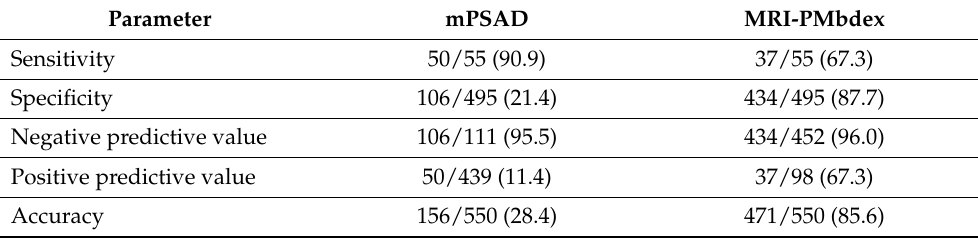
Table 4. Performance of mPSAD and MRI-PMbdex, with respective thresholds of 0.628 ng/mL 2 and 13.5%, in men with PI-RADS <